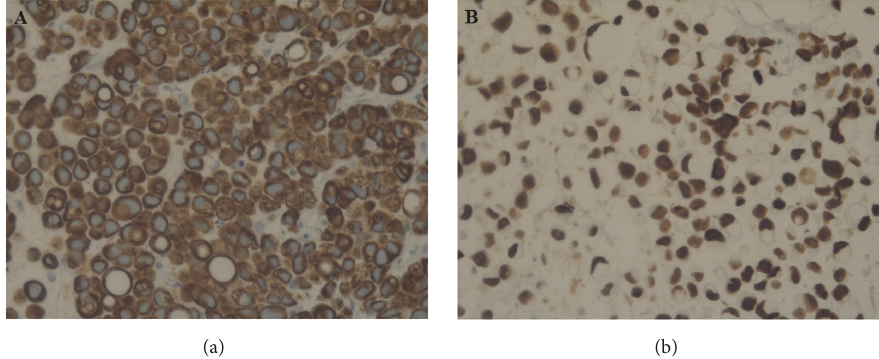
Figure 4: Immunohistochemistry revealing tumor cells positive for cytokeratin (CK) 7 (a) and thyroid transcription factor-1 (TTF1) (b). Immunostaining, x40 magnification.